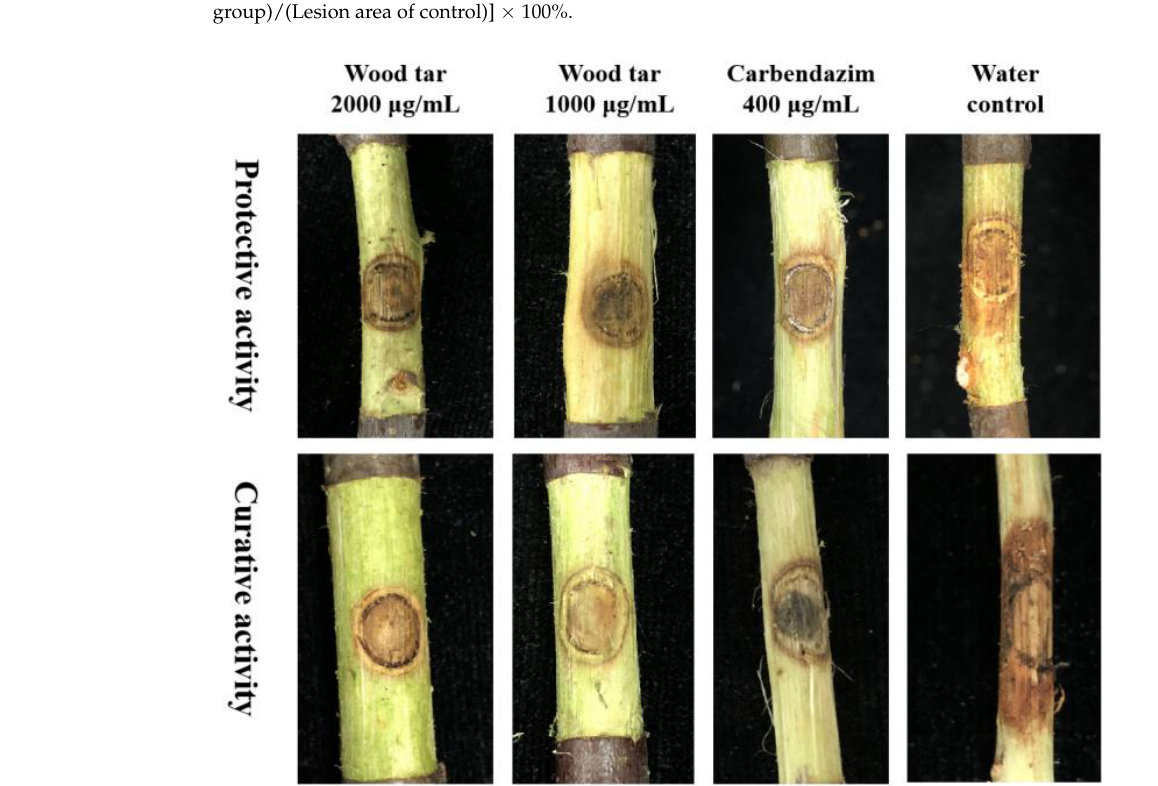
Table 2. Protective and curative activity of wood tar in controlling V. mali .